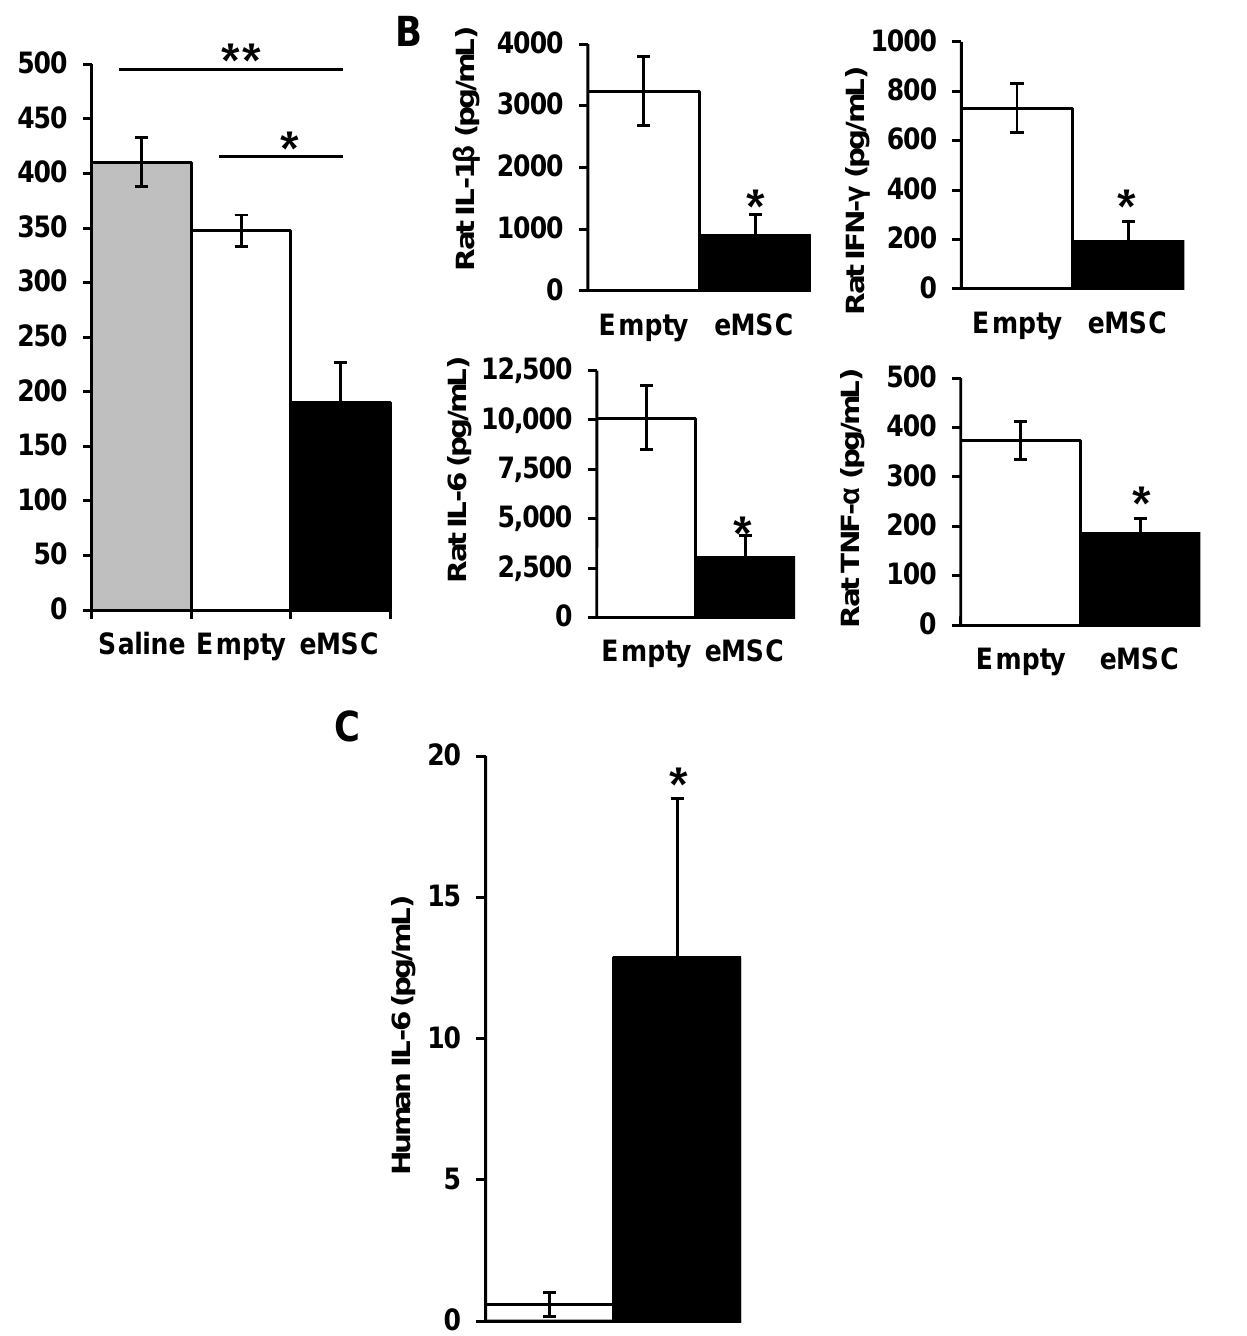
Figure 3. Effect of human eMSC in rat endotoxemia. ( A ) Expression of rat TNF-α in sera of rats injected with LPS and measured by ELISA after injection of saline alone or capsules without (empty) or with eMSC ( n = 3/group). ( B ) Multiplex assay of sera from cardiac puncture showed significant reductions in rat IL-1β, IL-6, IFN-γ, and TNF-α. ( C ) Human IL-6 levels in the rat were detected at significantly higher levels than empty capsules control. n = 5 for Empty and n = 3 for eMSC. One-Way ANOVA or student t -test was done to test significance between the groups. * p < 0.05 and ** p < 0.01.